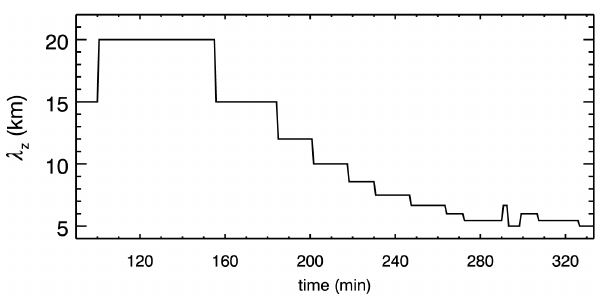
Figure 4. Temporal evolution of the vertical wavelength for the case EM.